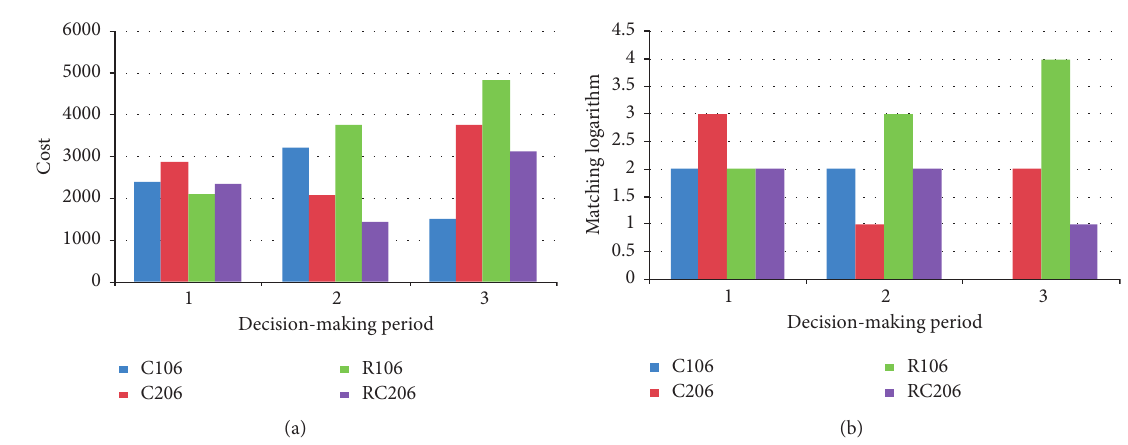
Figure 6: Comparison of two-stage disruption adjustment results. (a) Generalized deviation cost comparison. (b) Abandonment of service comparison.